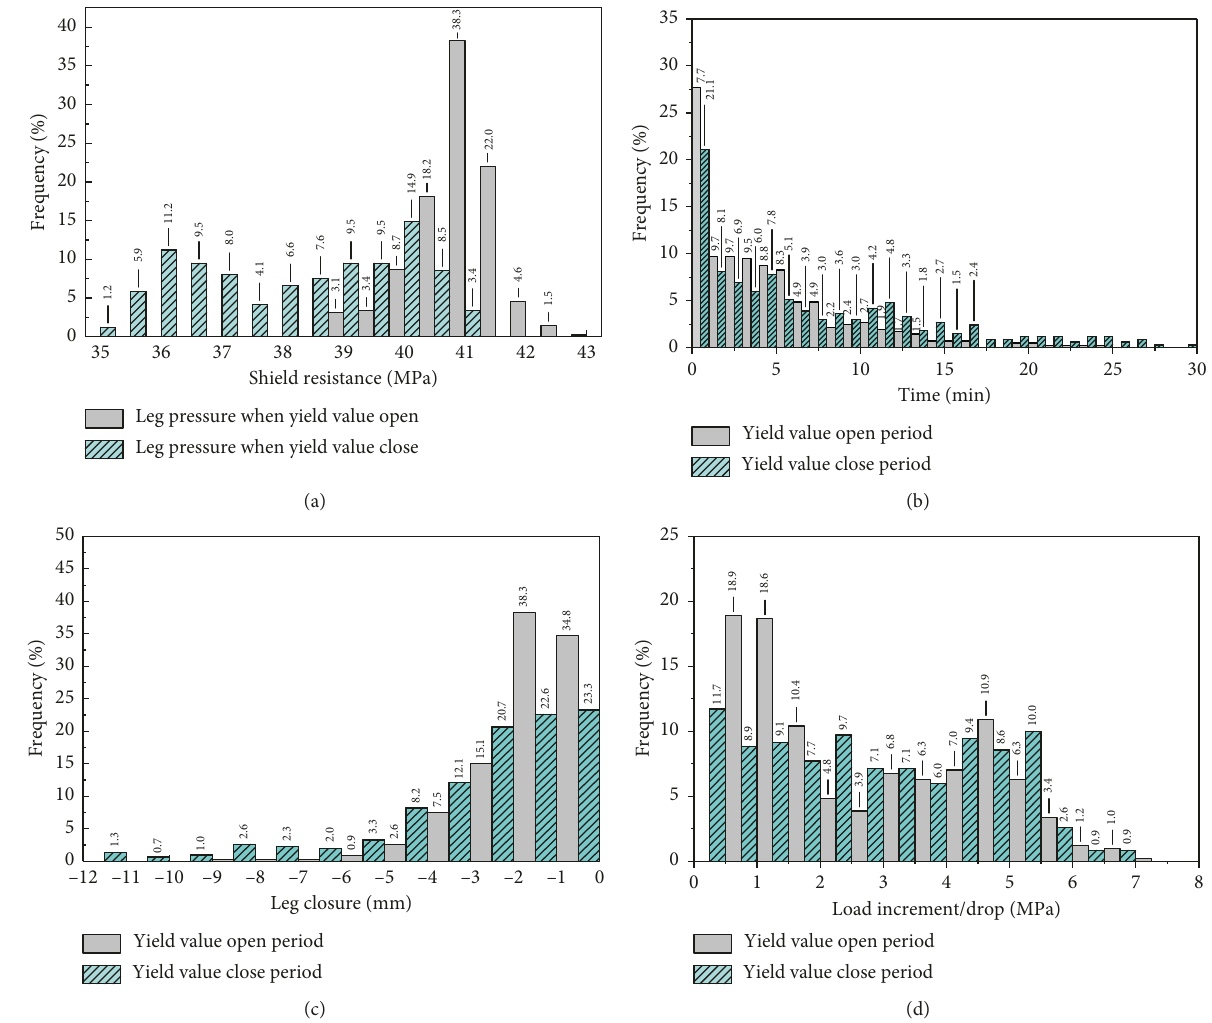
Figure 17: Yield valve malfunctions. (a) Frequency distribution of close and open pressure of yield valve. The setting yield pressure is 41MPa. (b) Frequency distribution of open and close duration of yield valve. (c) Frequency distribution of leg closure during yield open and close. (d) Frequency distribution of pressure increment/drop during yield open and close.